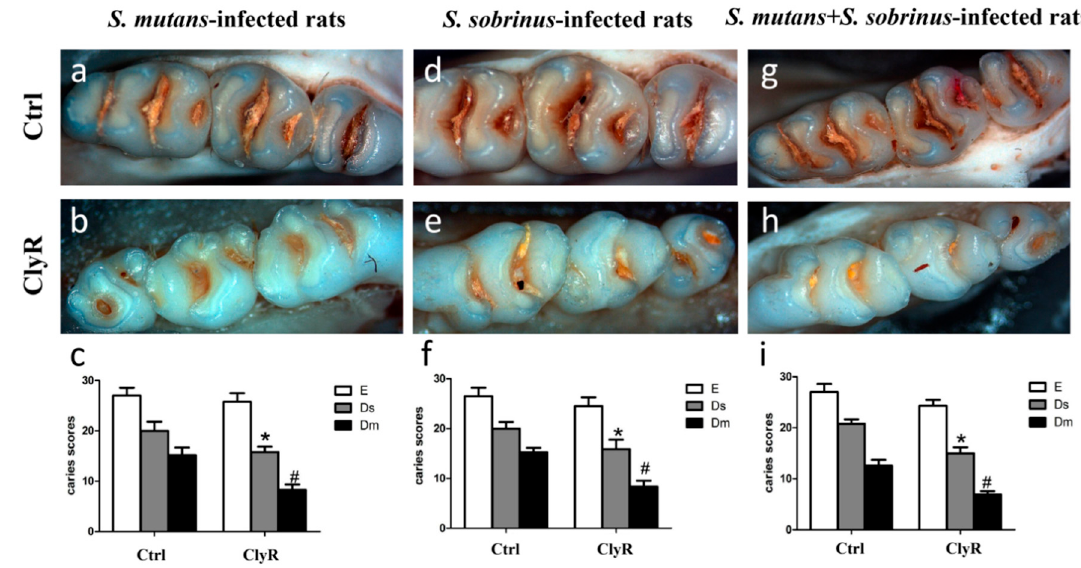
Figure 5. Effect of ClyR on the development of dental caries in rats (representative teeth images and